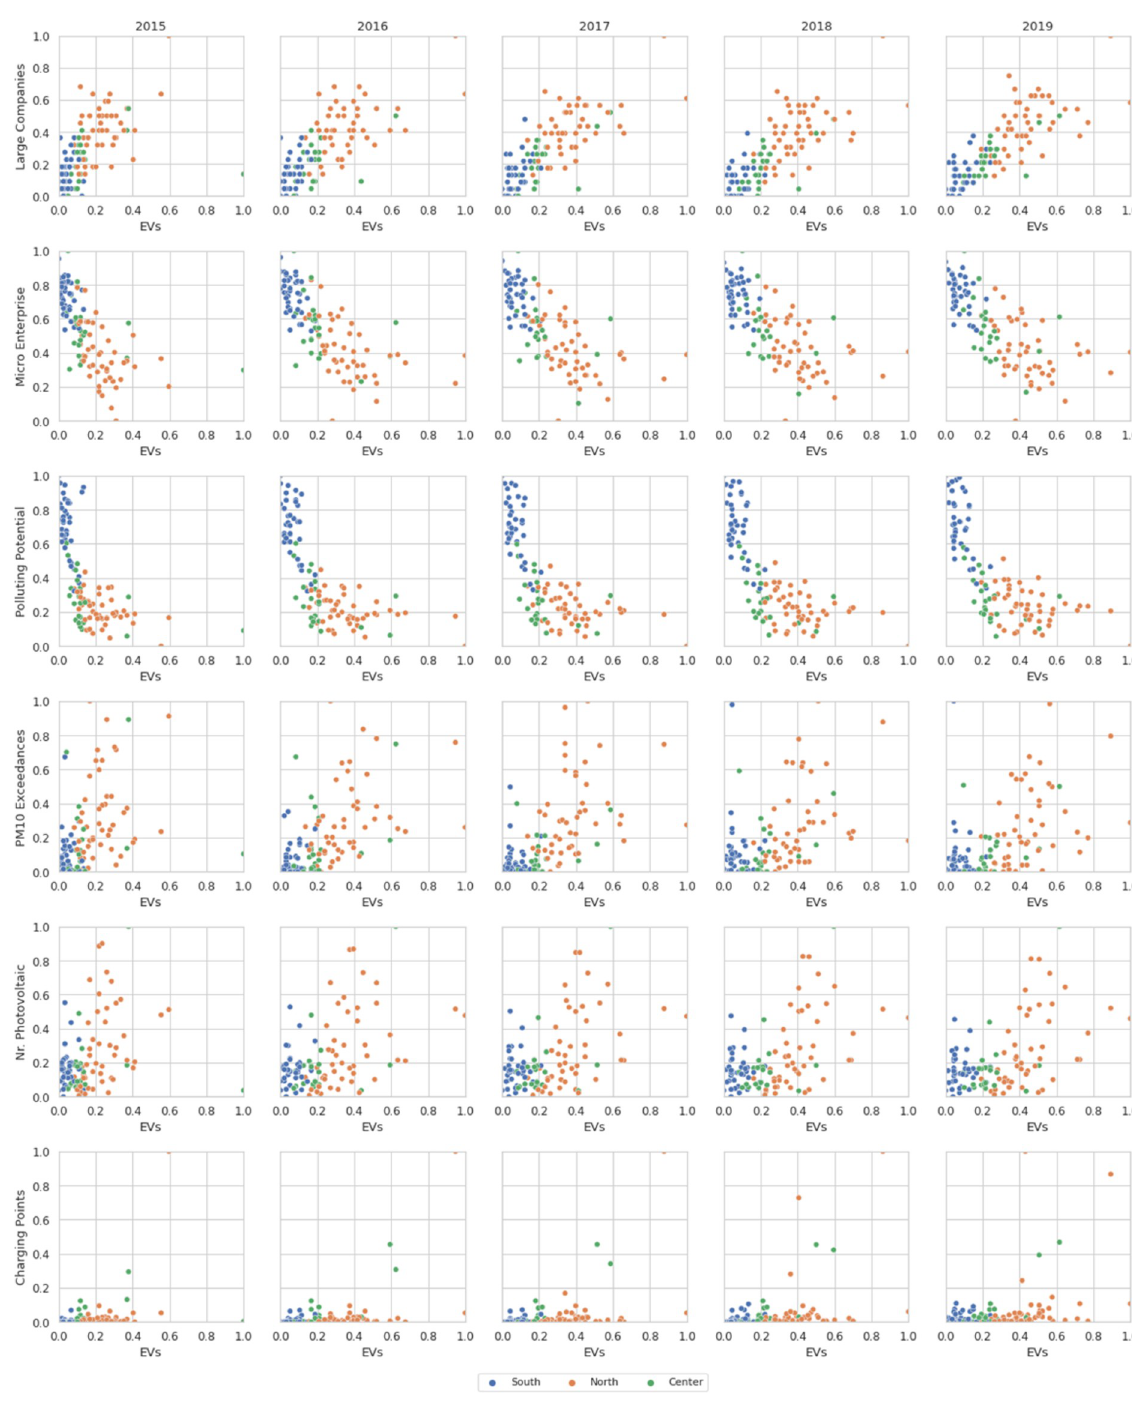
Fig 6. Scatter plots matrix with the target variable (regional percentage of EVs) of the following features: Large Companies , Micro Enterprises , Polluting Potential , PM10 Exceedances , Number of Photovoltaic Panels and Number of Charging Points .